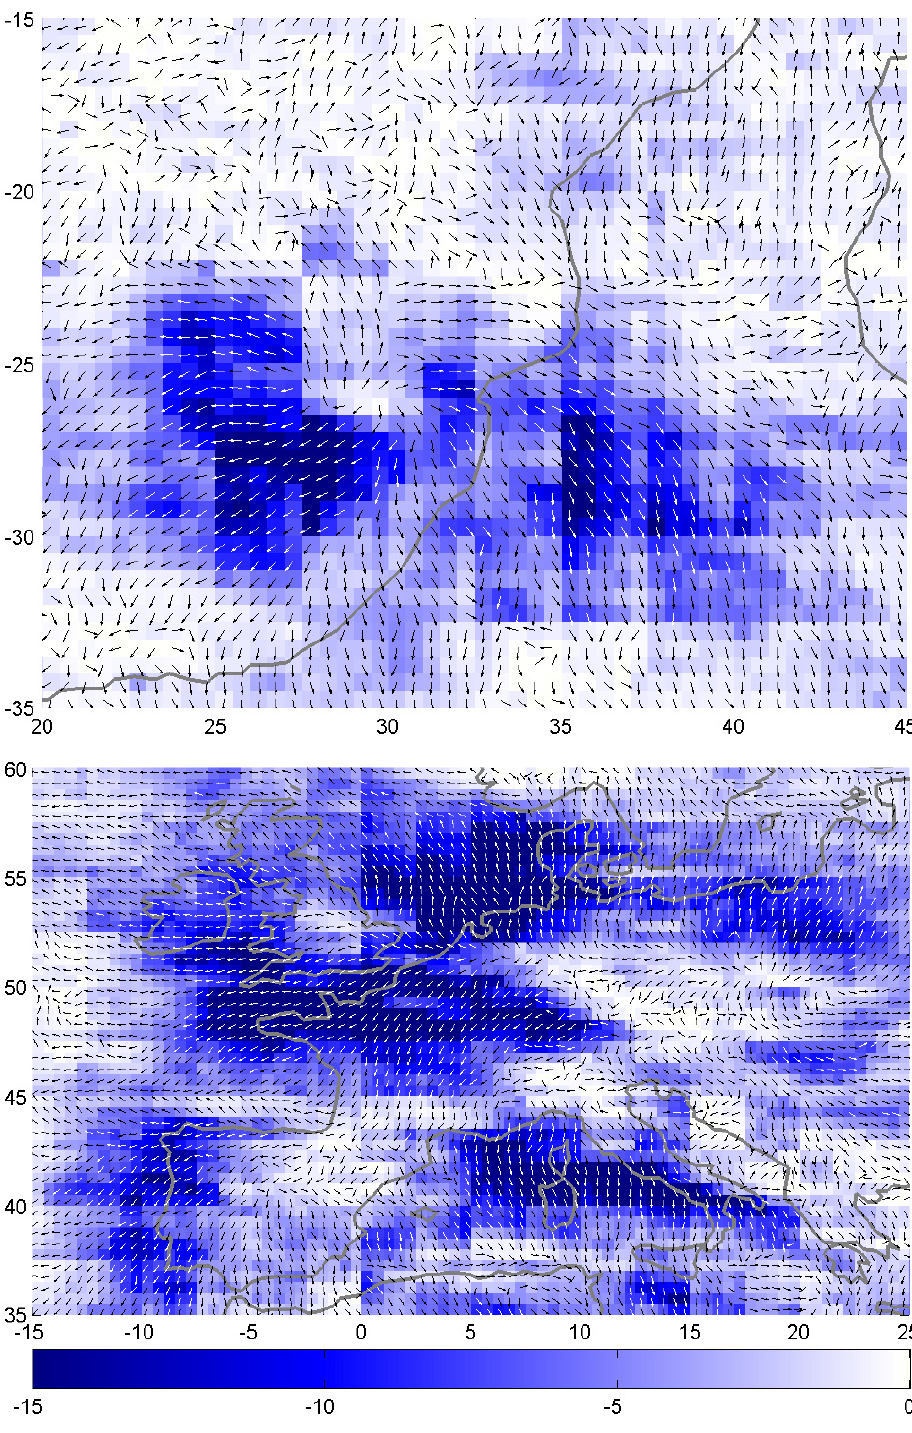
Fig. 10. Wind direction of maximum TVCD as quiver-plot (compare Fig. 7a) for the region (a) around Johannesburg, South Africa and (b) over Europe. Also the significance as in Fig. 3d is shown (strength of the blue